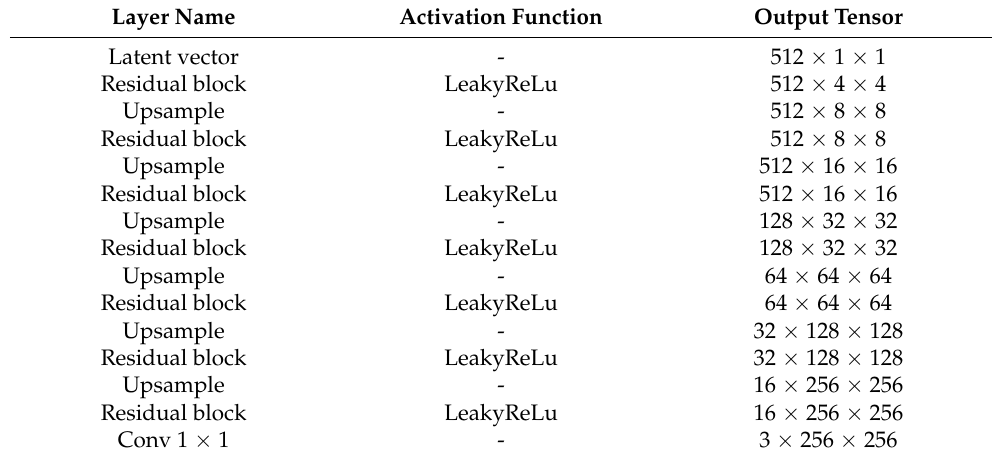
Table 3. Generator-related parameters of PWGAN-GP.